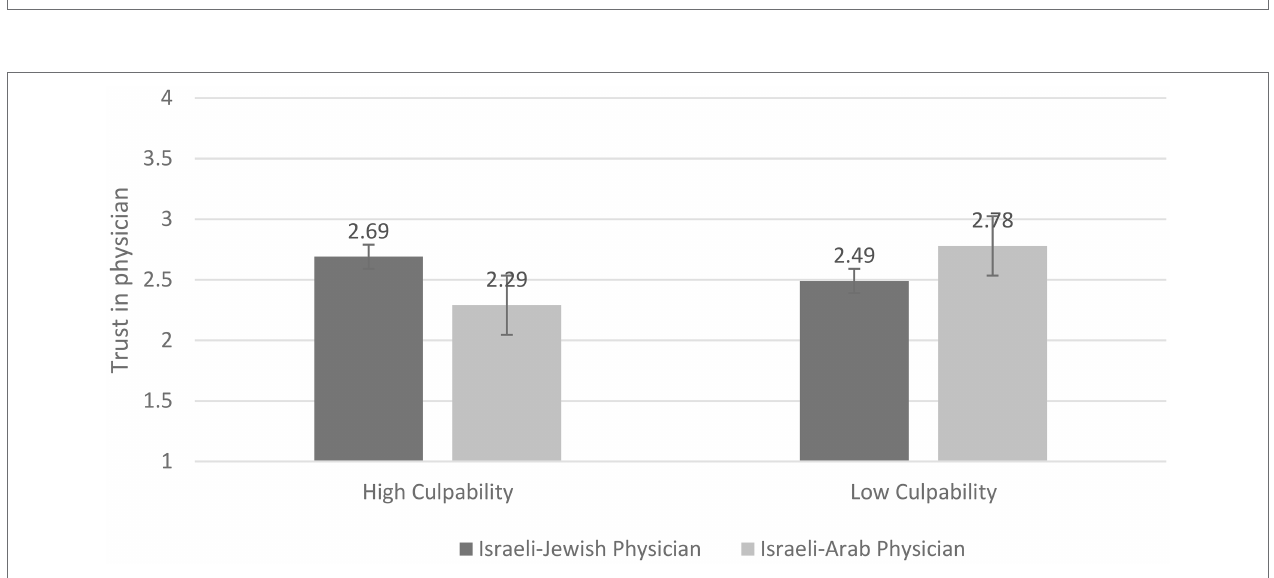
FIGURE 1 | Emotions toward Physician as a Function of Physician’s Ethnicity and Culpability.